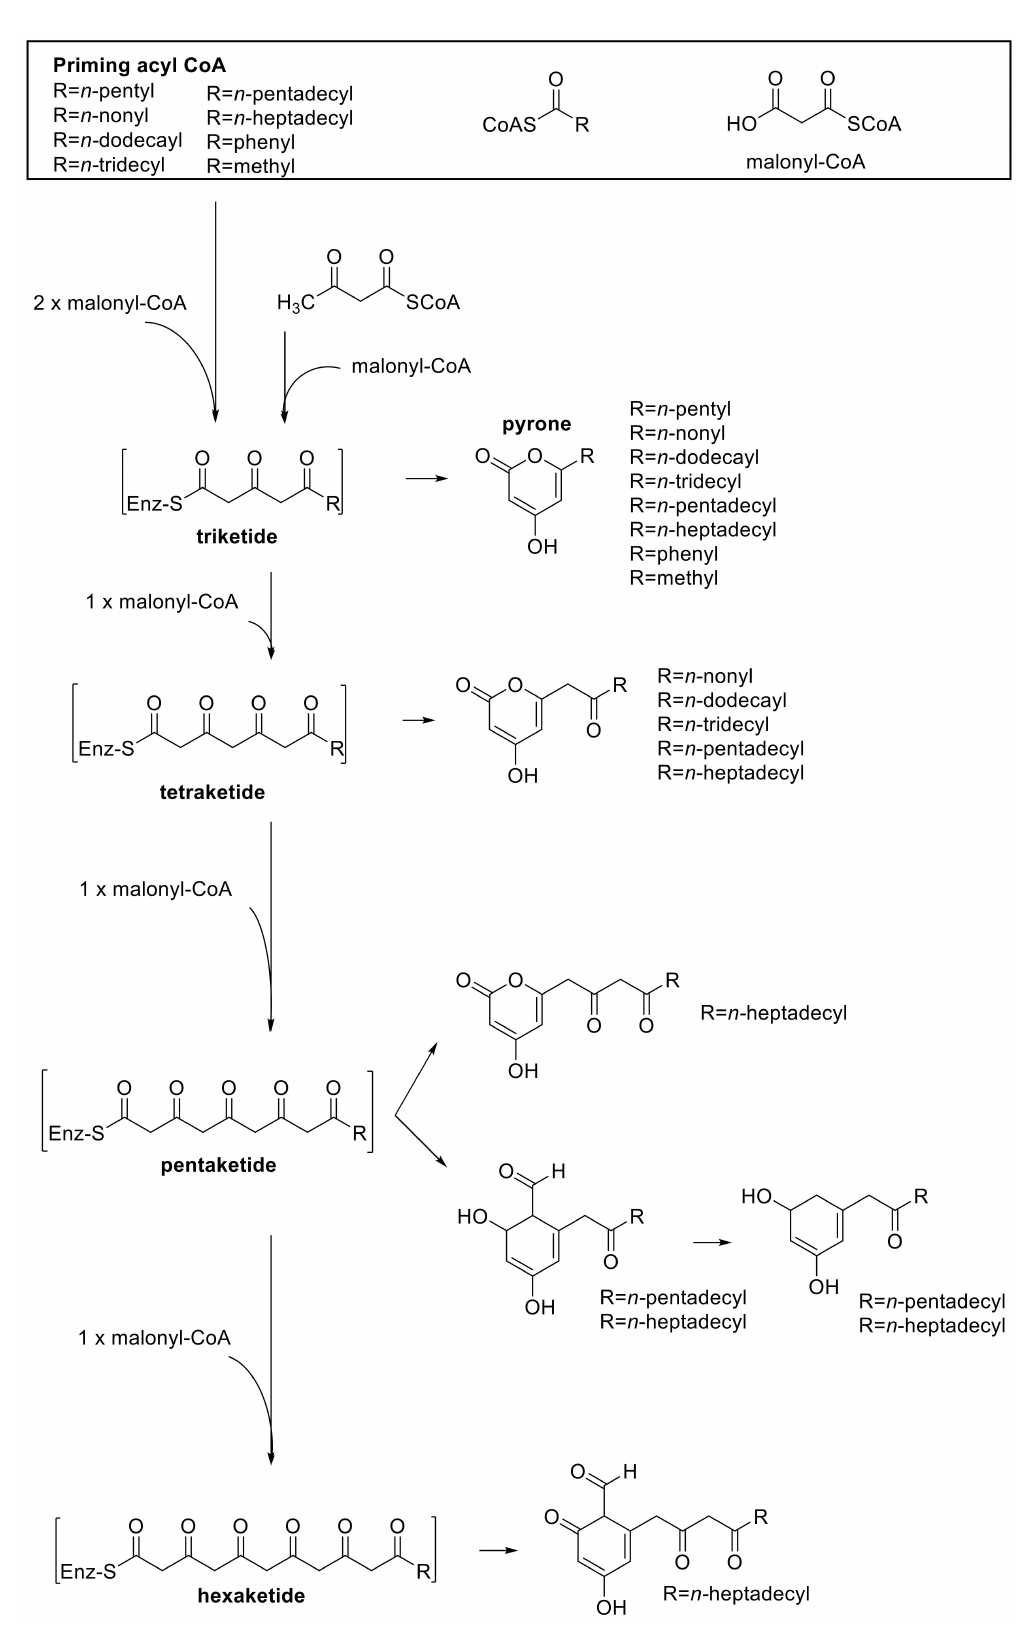
Figure 8. Summary of BPKS reactions with various acyl-CoA starter